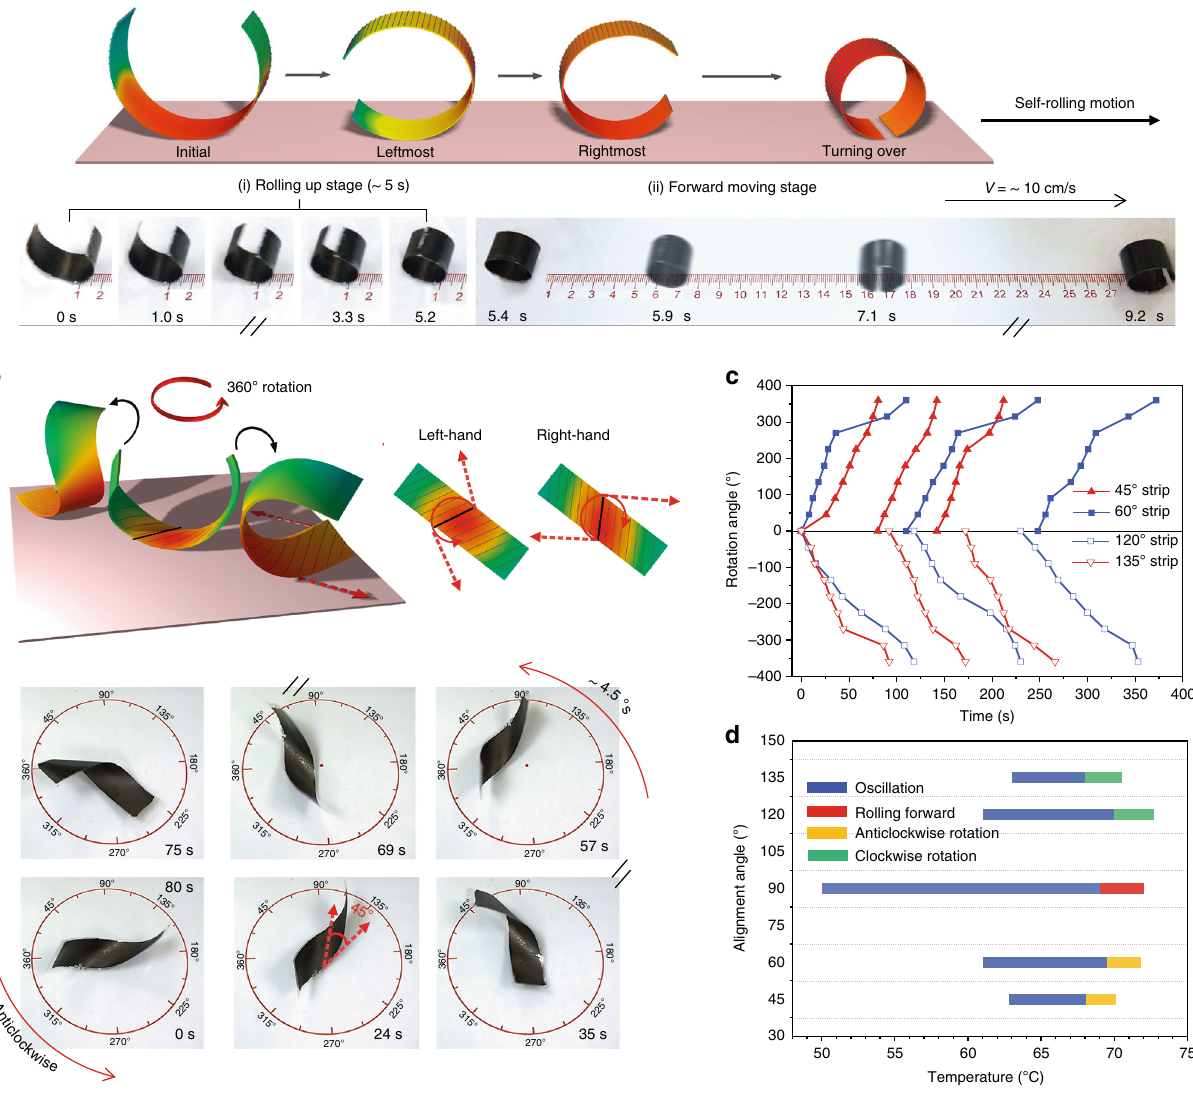
Fig. 4 Realization of self-propelled multimodal locomotions. a Schematic representation and snapshots of a self-rolling motion of TMES at α = 90° on a hot surface at 70 °C. b Schematic illustration of self-rotation movement with direction determined by the alignment angle of PVDF in TMES, and snapshots of TMES at α = 45° during an anticlockwise rotation process. c Time-dependent rotation angle of TMES at four different alignment angles during three consecutive 360-degree rotation cycles. d The locomotion modes of TMES strips at different alignment angles on the hot surface with temperatures ranging from 50 to 75